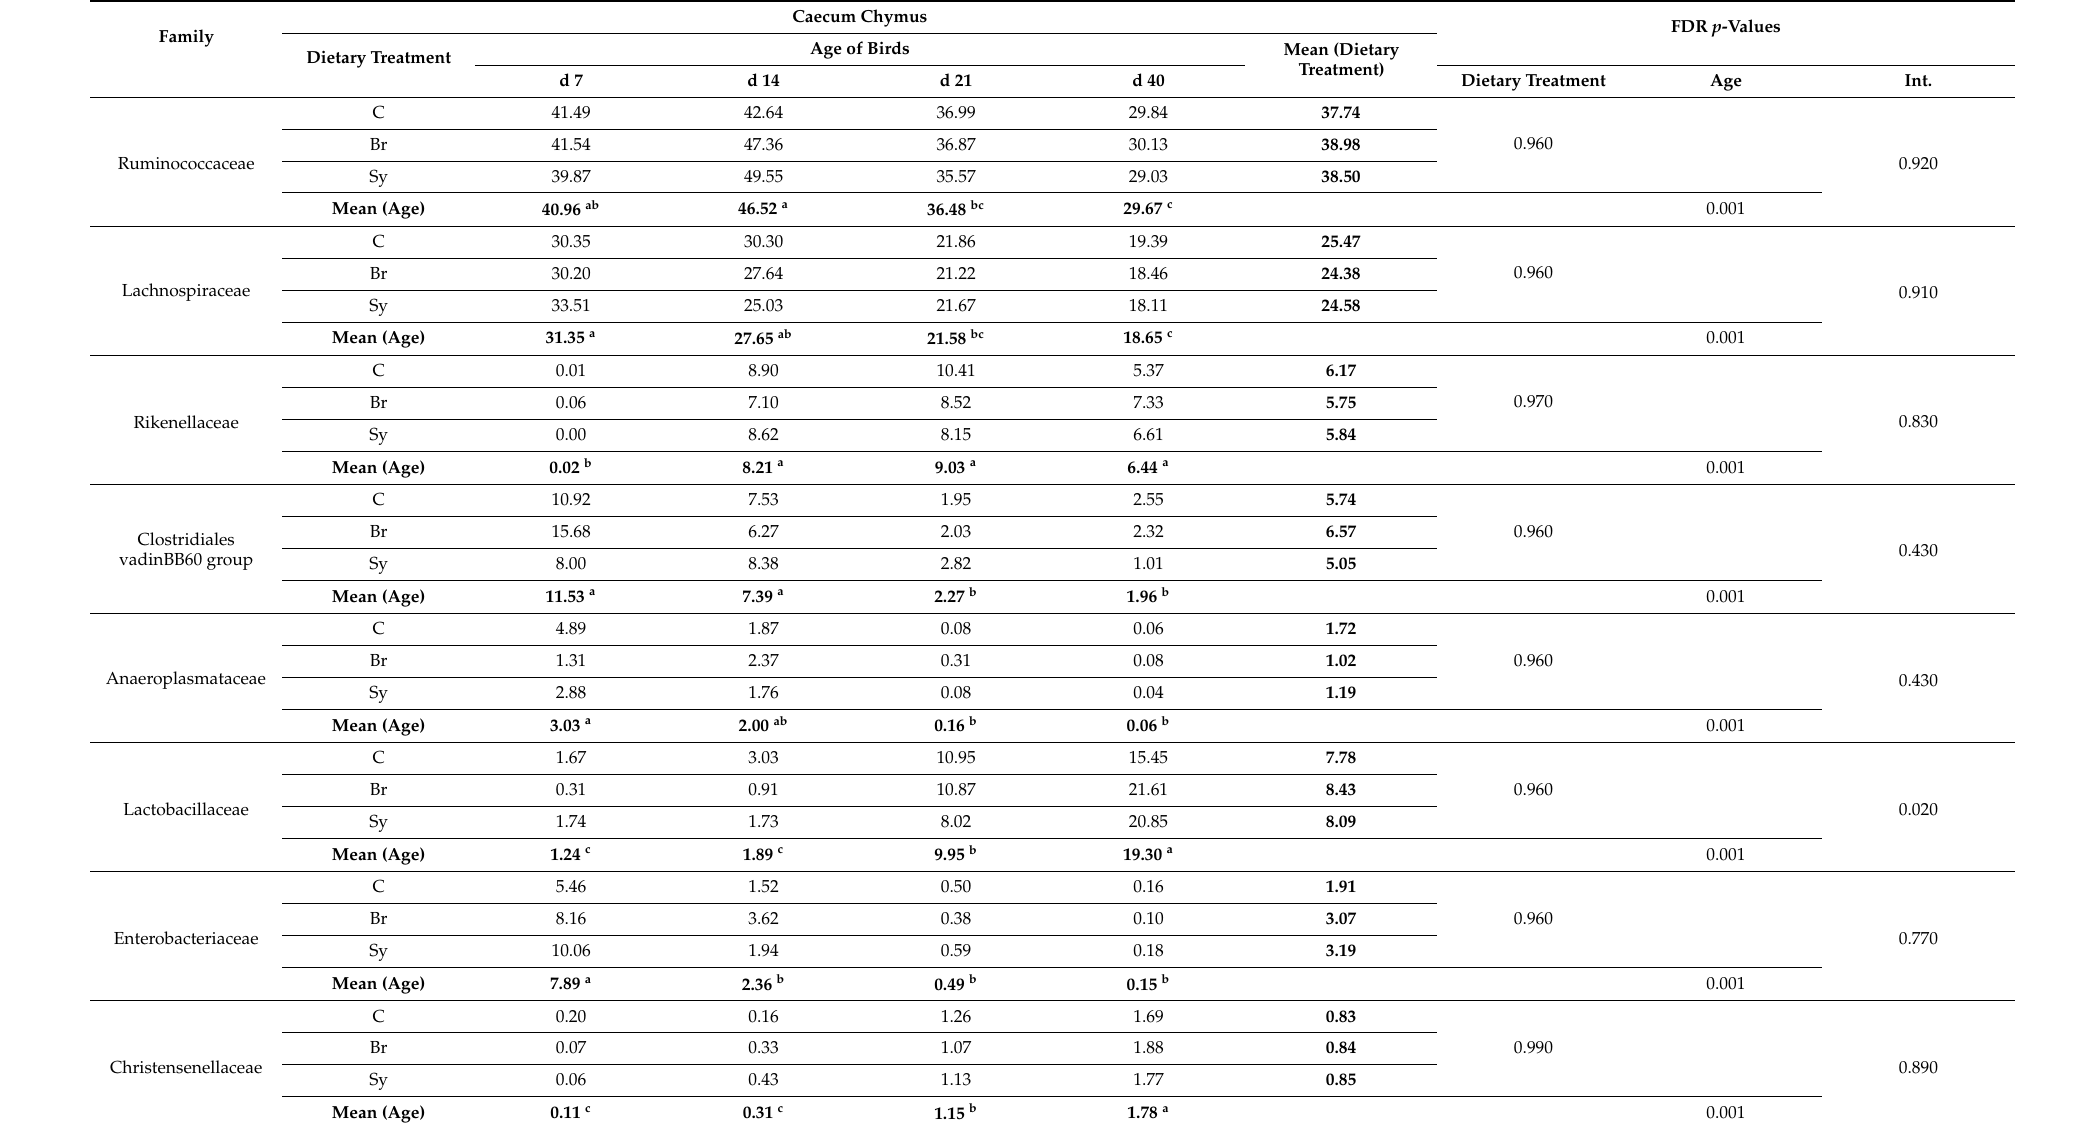
Table 5. Relative abundance of bacterial families in the caecum chymus of broiler chickens as affected by dietary treatments and age (%). Caecum Chymus FDR p -Values Family Dietary Treatment Age of Birds Mean (Dietary Treatment) d 7 d 14 d 21 d 40 Dietary Treatment Age Int.